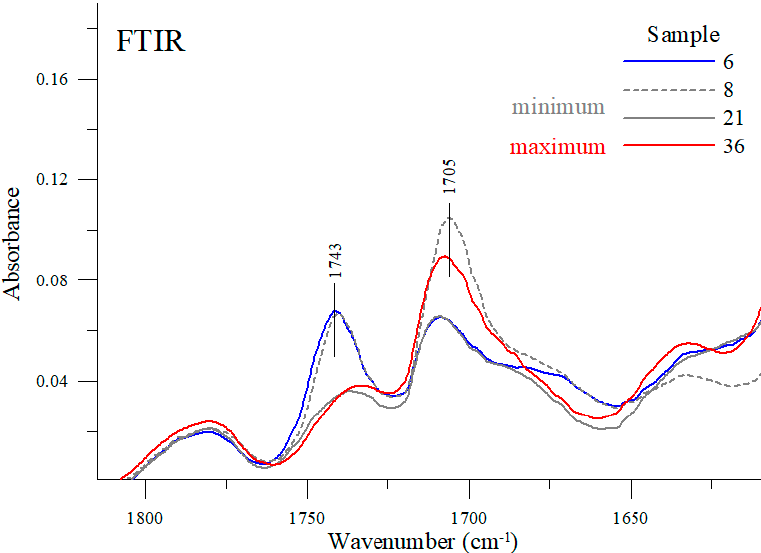
Figure 10. FTIR spectra of selected samples in the spectral range 1815–1610 cm − 1 .